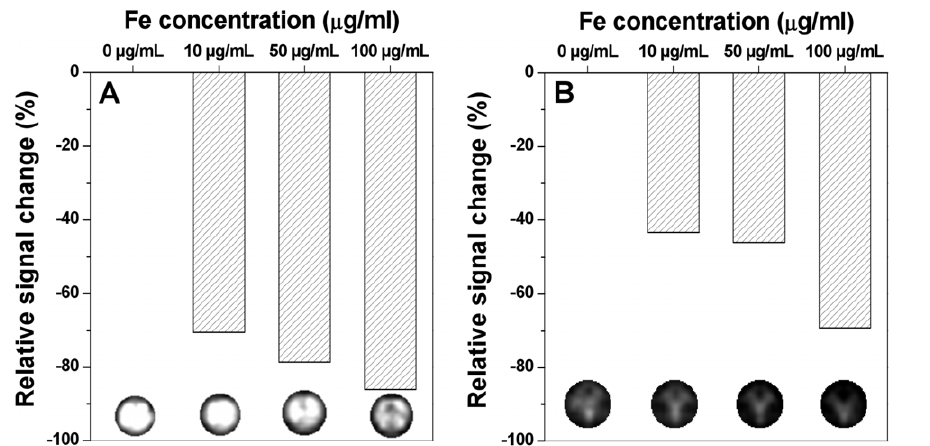
Figure 6. Evaluation of Mag@SiO2 nanoparticles as a T2 MR contrast agent is shown in the form of % signal enhancement with increasing concentration of Fe using a 3 Tesla MR scanner. Panel A shows the studies performed in phantoms for particles in suspension, while panel B shows the similar studies in PC3 human prostate cancer cells after nanoparticles uptake for 24 h. Corresponding T2-weighted MR images of different samples, showing the image darkening effect with increasing Fe concentration are also shown under each bar.